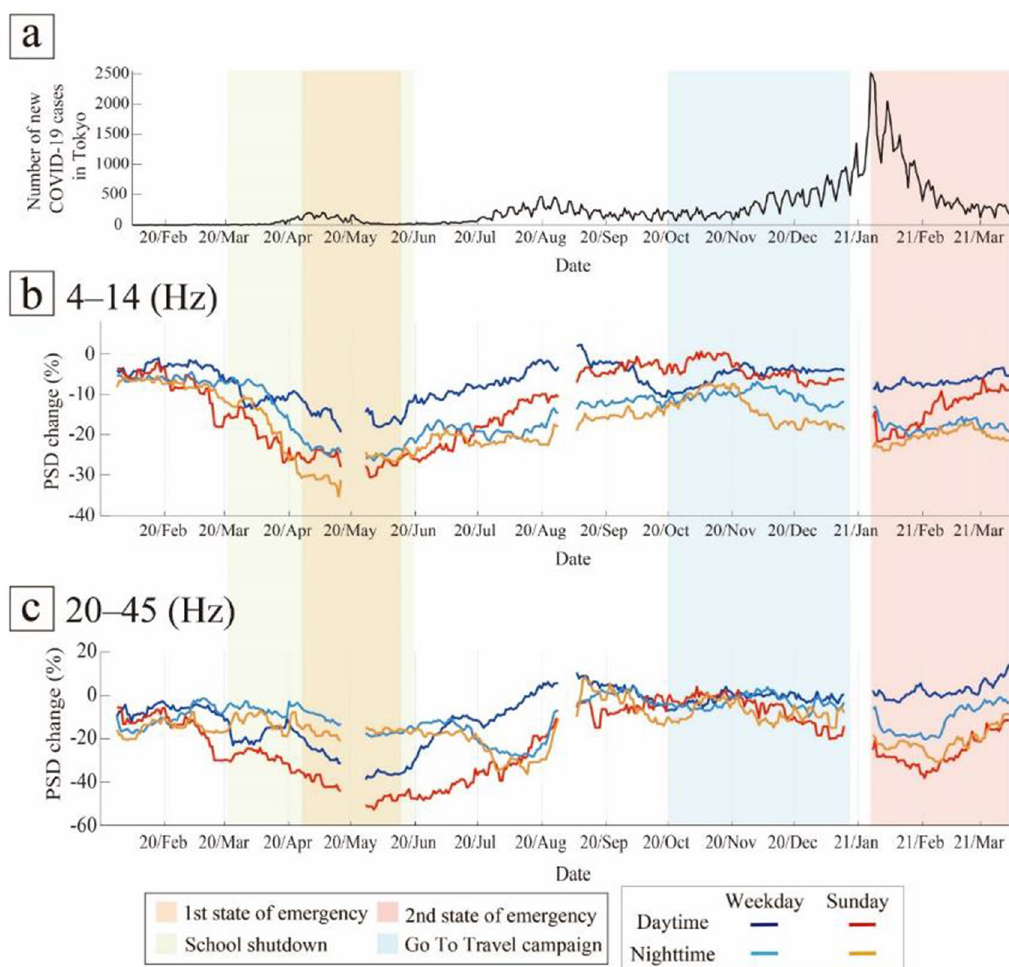
Figure 8. ( a ) Number of new COVID-19 cases in Tokyo (same as Fig. 1). ( b , c ) Comparison between temporal changes in the noise level in the frequency ranges ( b ) 4–14 Hz and ( c ) 20–45 Hz. The orange and pink shaded areas represent the periods of the first and second states of emergency in Tokyo, respectively; the green shaded area represents the period of school closures; and the light blue shaded area represents the period of the Go To Travel